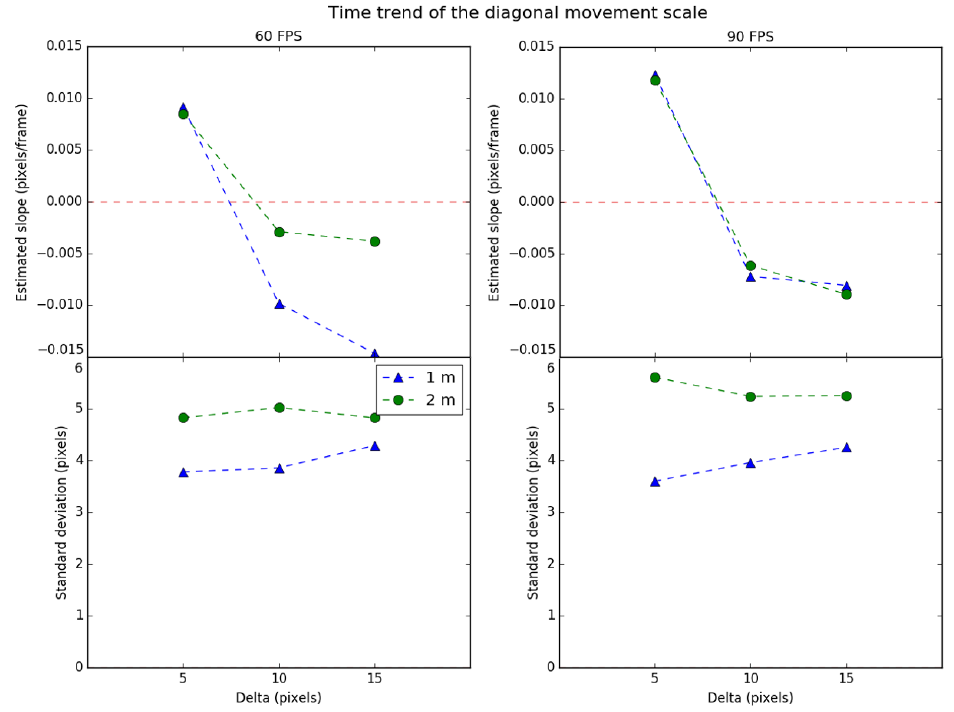
Figure 11. Time trend and variability of the scale for diagonal